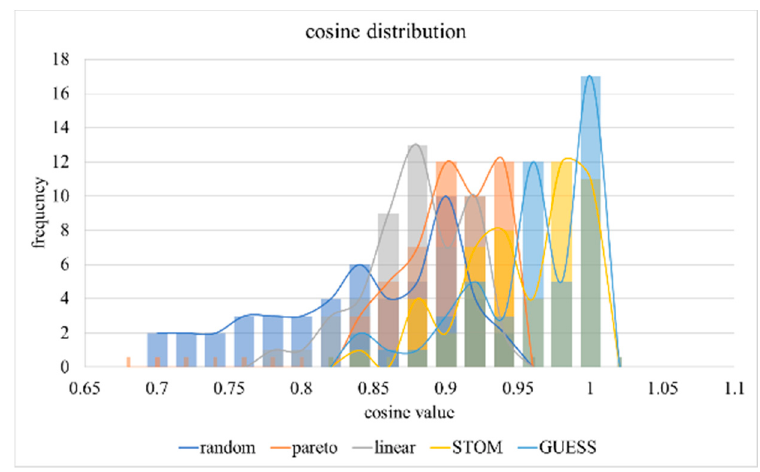
Figure 8. Distribution of f (1) / f (2) ratio.